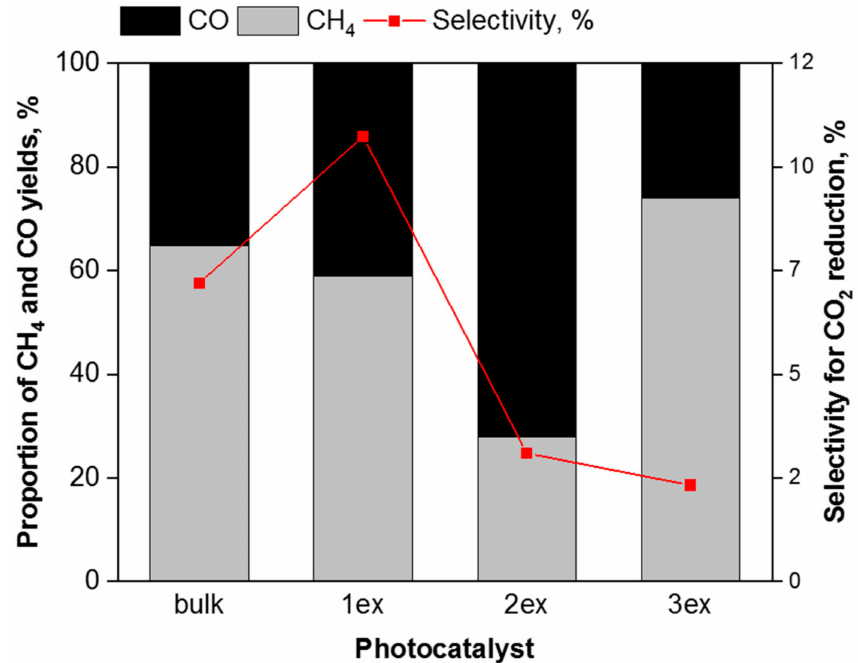
Figure 13. Correlation between the proportion of CO, CH 4 and H 2 yields and selectivity for the CO 2 photocatalytic reduction (after 8 irradiation hours) over the g-C 3 N 4